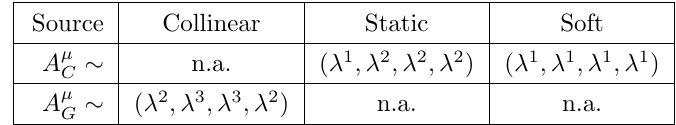
Figure 5 . A characteristic single Glauber/Coulomb gluon insertion vertex from the Lagrangian , where the incoming quark caries momentum p (cid:22) = mv (cid:22) + r (cid:22) and the outgoing p 0 (cid:22) = L Q (cid:0) G=C mv (cid:22) + r 0 (cid:22) .